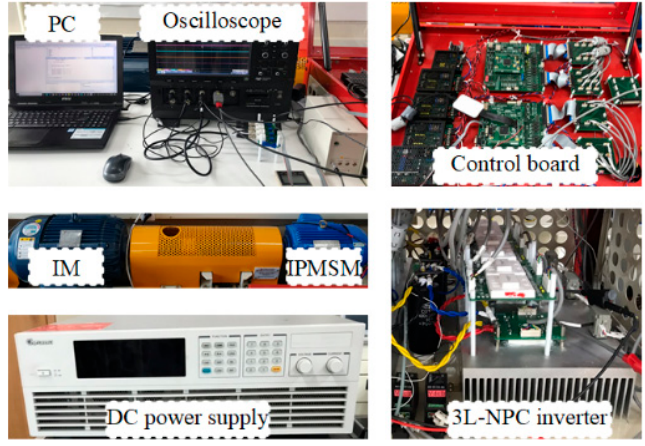
Figure 13. Experimental setup.